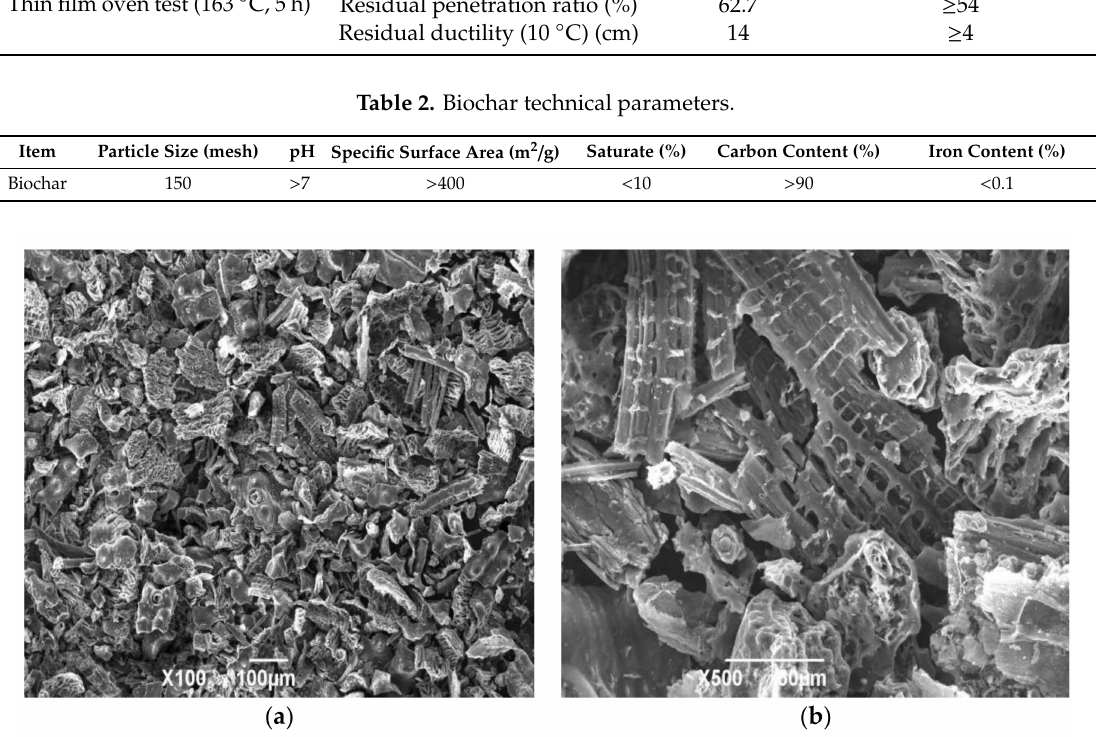
Figure 1. Biochar particles with di ff erent amplification ratios: ( a ) × 100; ( b ) ×